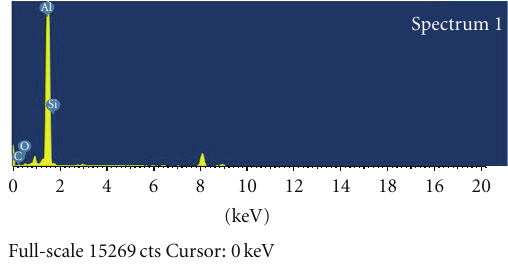
Figure 7: EDAS of Al-SiC nanocomposites.